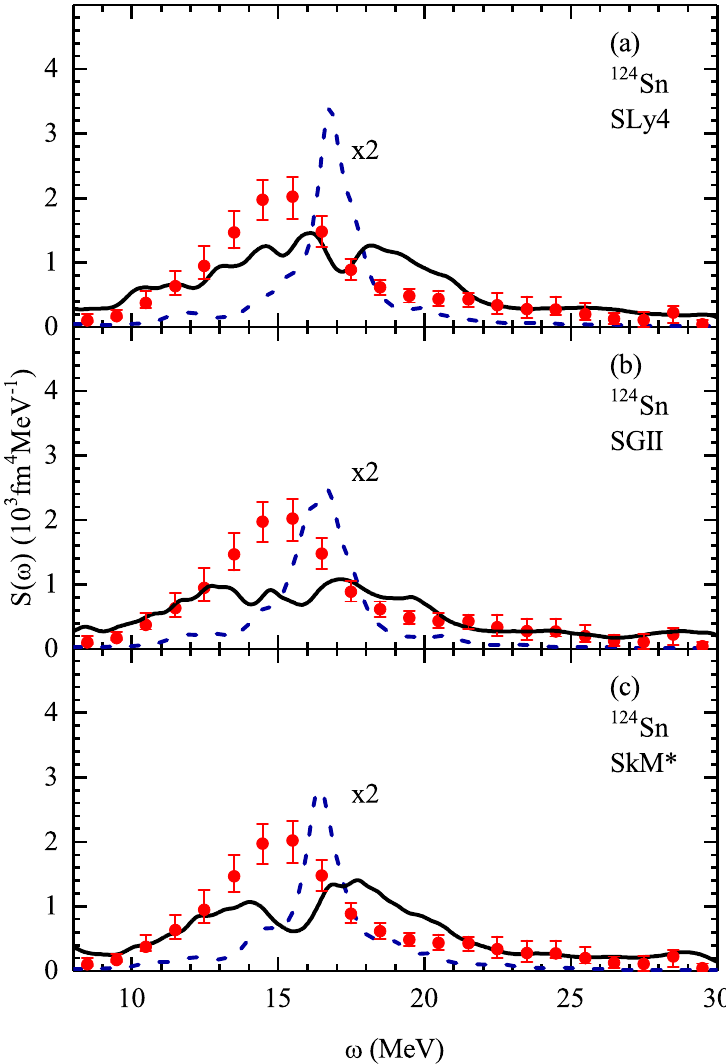
Figure 2. The calculated ISGMR strength distributions in 124 Sn are compared with the experimental data from [10] using the Skyrme forces SLy4 (panel ( a )), SGII (panel ( b )), and SkM ∗ (panel ( c )). The QRPA results (dashed curves) are scaled down by a factor of 2 for a better display. The solid curves correspond to the results obtained by means of the coupling between the one- and two-phonon configuration. The smoothing parameter 1 MeV was used for the strength distribution described by the Lorentzian